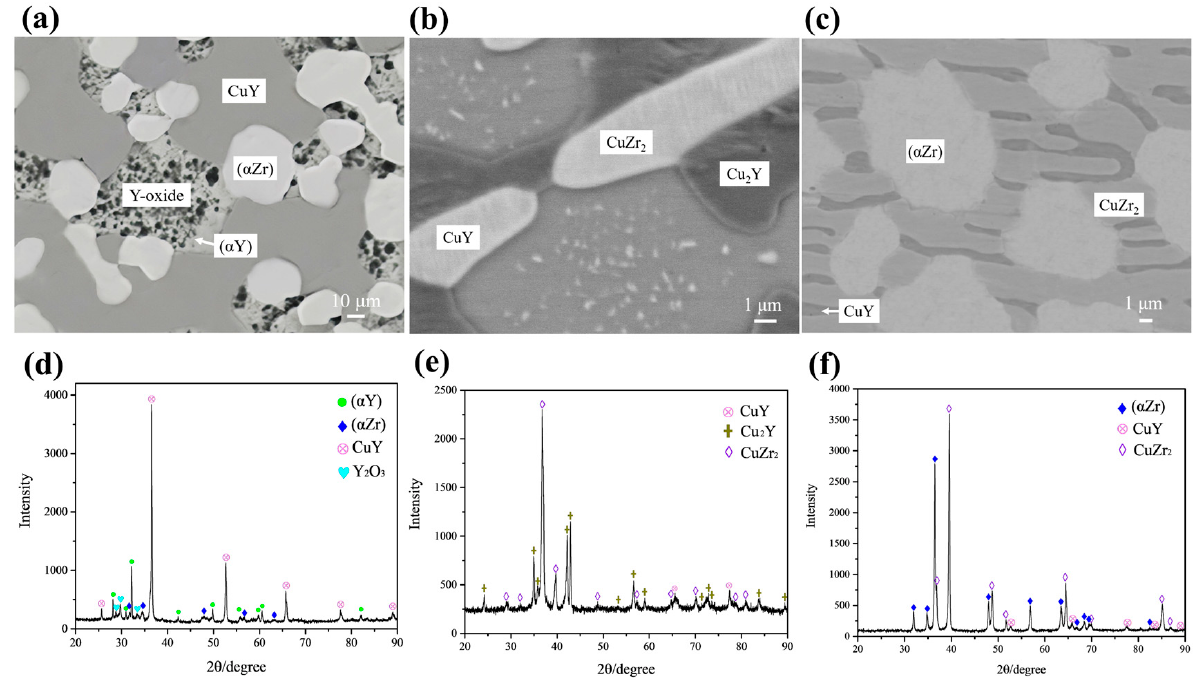
Figure 8. BSE micrographs and XRD patterns of annealed alloys: ( a , d ) A4 Cu 33 Zr 7 Y 60 (at.%); ( b , e ) A9 Cu 53 Zr 12 Y 35 (at.%); ( c , f ) A10 Cu 22 Zr 71 Y 7